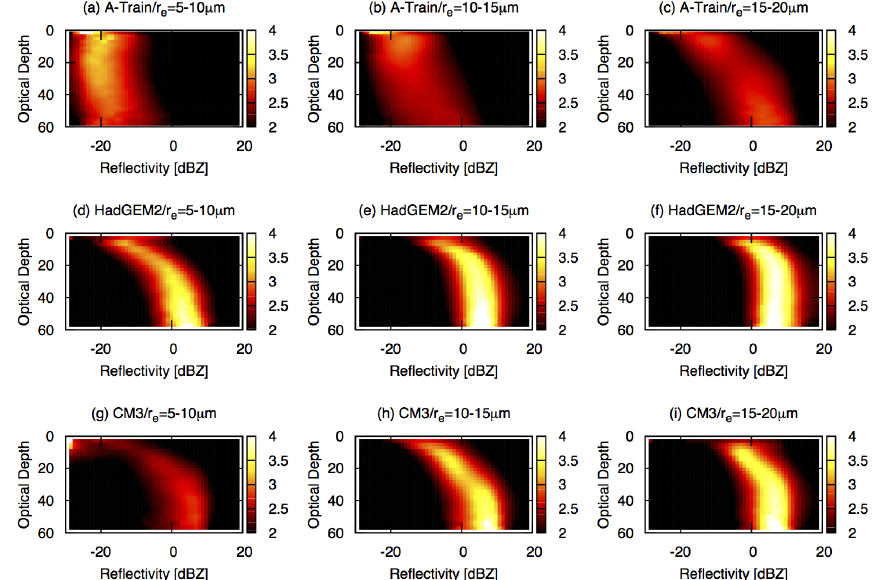
Figure 10. Examples of the CFODD statistics obtained from CloudSat and MODIS satellite observations (upper), UKMO/HadGEM2 (mid- dle) and GFDL/CM3 (bottom) reproduced with data of Suzuki et al. (2015). The colour shading shows the probability density function of radar reflectivity (%dBZ − 1 ) normalized at each in-cloud optical depth. The statistics are classified according to the cloud-top effective particle radius (left to